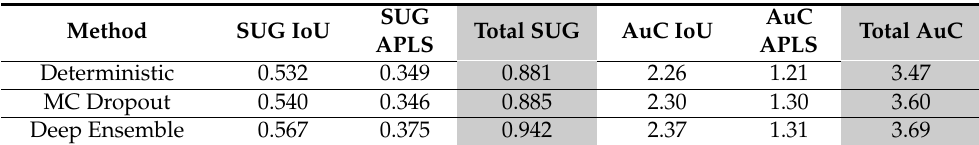
Table 1. Best model results on test data, selected from multiple training runs. Each score is the average over all image chips in the test set. MCD matches DEs on APLS, but DEs perform best overall.